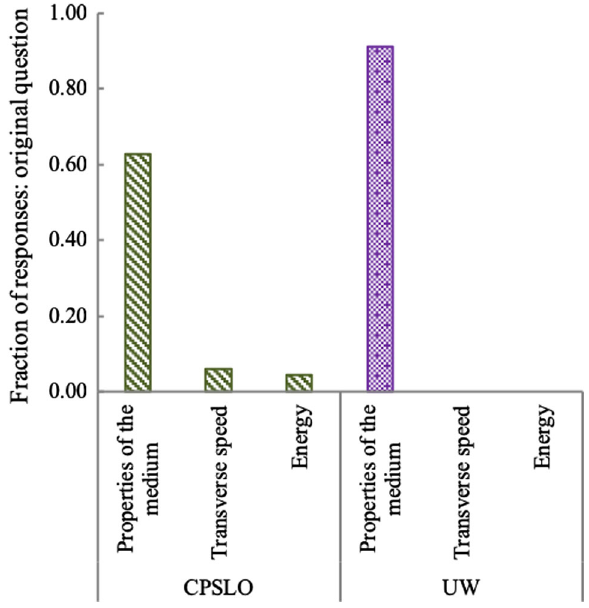
FIG. 3. Fraction of responses using three common resources for the original pulse-flick